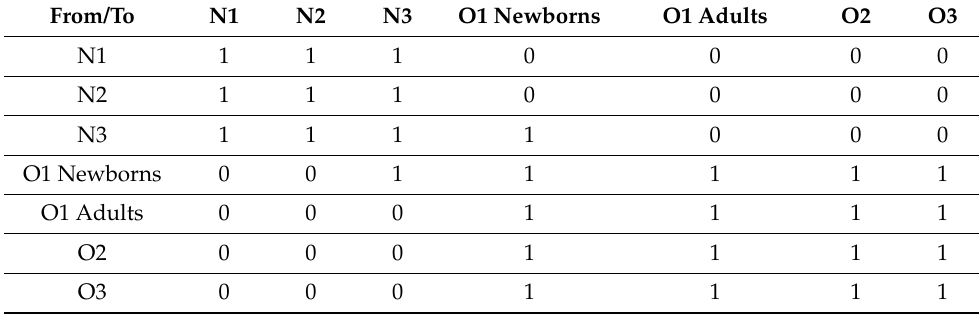
Table A1. Skill matrix for Model 1 for the Perinatology Care System, Configuration 1. From/To